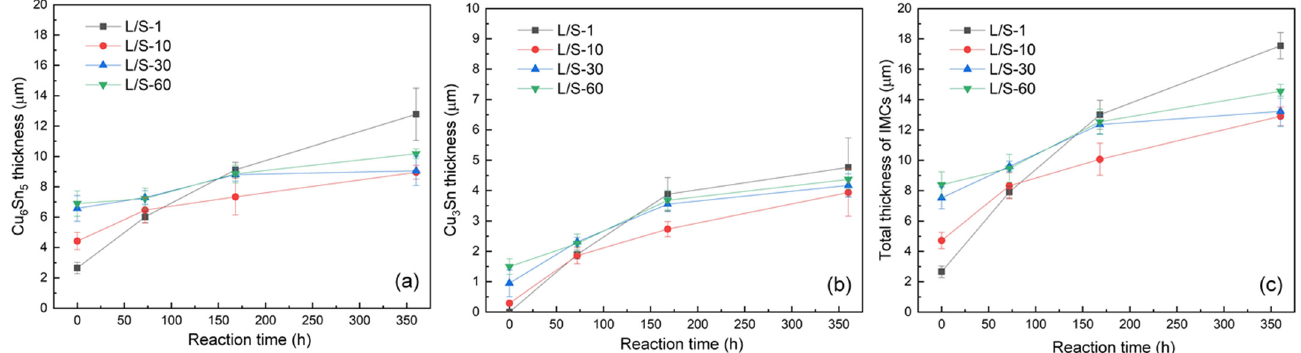
Figure 4. Thicknesses of the IMCs as a function of the solid/solid reaction time for various liquid/solid joints: ( a ) Cu 6 Sn 5 , ( b ) Cu 3 Sn, and ( c ) Cu 6 Sn 5 + Cu 3 Sn. Table 2. Growth rate constants ( k ) of Cu 6 Sn 5 , Cu 3 Sn, and Cu 6 Sn 5 + Cu 3 Sn for thermal aging (solid/solid) reactions at 200 ◦ C (unit: µ m/h 0.5